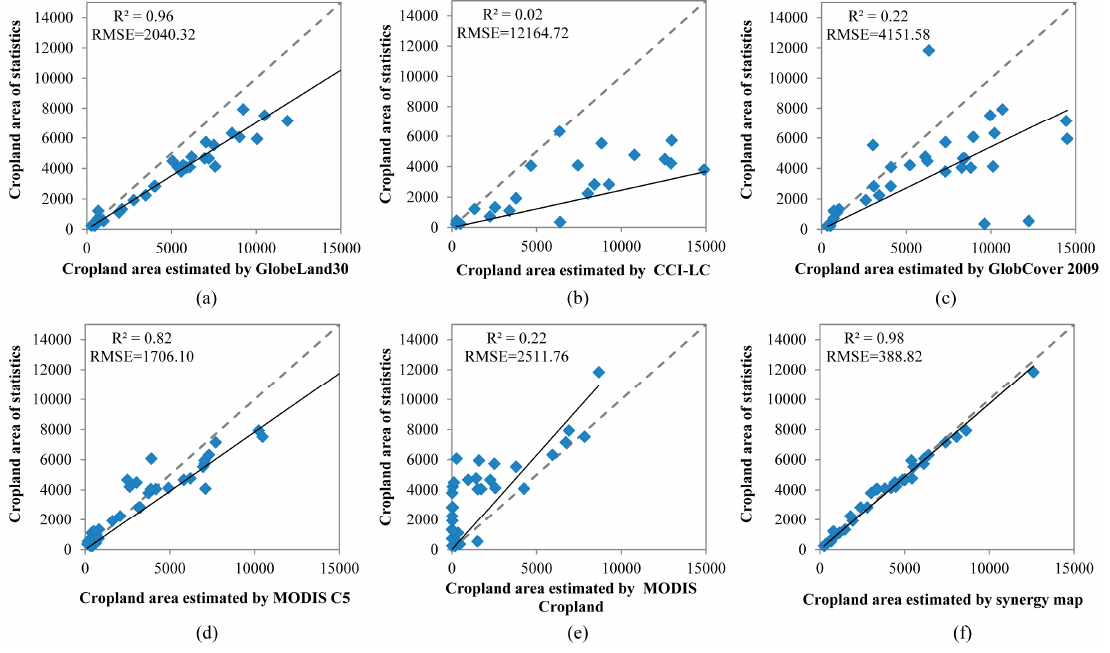
Figure 10. Scatterplots of cropland area from statistics and those estimated by GlobeLand30 ( a ); CCI-LC ( b ); GlobCover 2009 ( c ); MODIS C5 ( d ); MODIS Cropland ( e ) and synergy map ( f ).